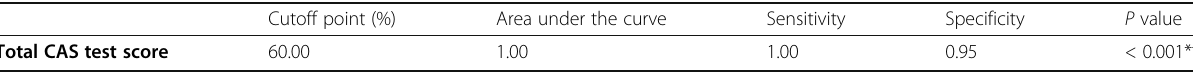
Table 6 Cutoff points by percentage for differentiation between group I and group II Cutoff point